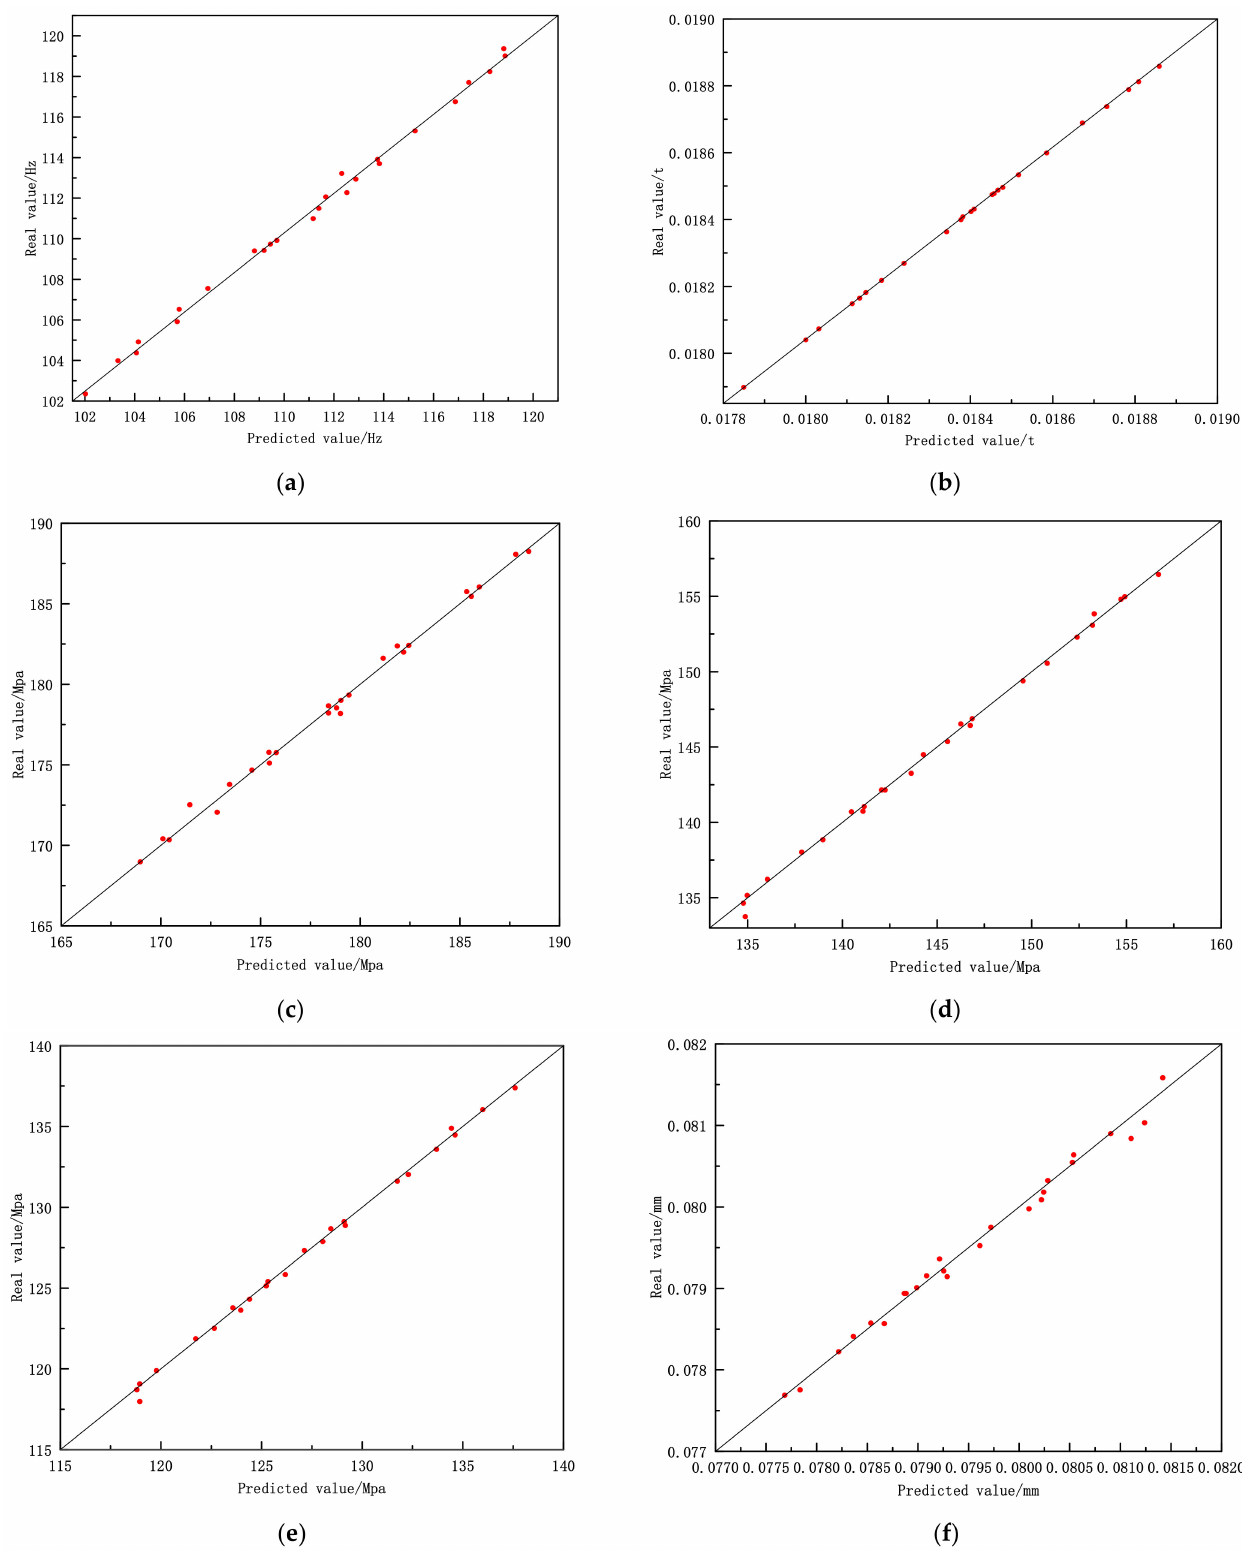
Figure 11. The fitting results of the predicted and actual response values of the aluminium alloy front subframe. ( a ) Results of first-order modal frequency fitting. ( b ) Mass fitting results. ( c ) Stress fitting results of over one side deep pit condition. ( d ) Stress fitting results of forward braking condition. ( e ) Stress fitting results of forward emergency braking condition. ( f ) Fitting results of the maximum displacement of the right front point of the lower